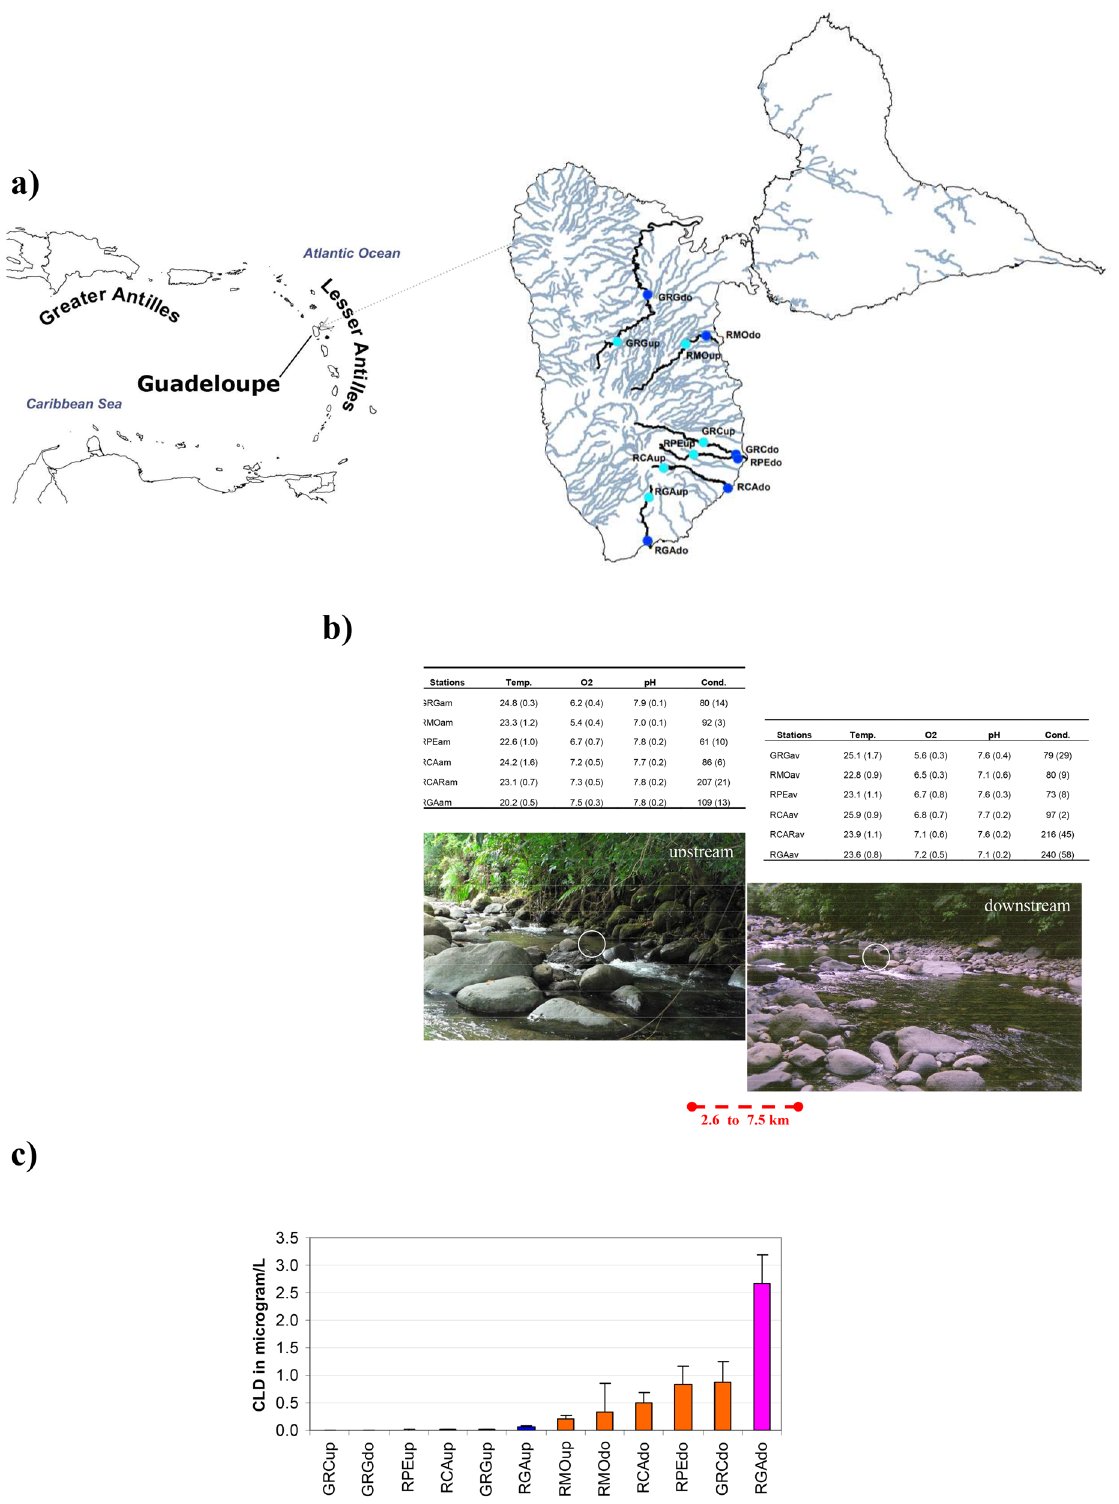
Figure 1. ( a ) Map of the sampling stations on the Basse-Terre region (French West Indies). Localisation of the upstream (lightblue) and downstream (darkblue) sampling sites in 6 different rivers. Grande rivière à Goyaves River: GRG, Moustique River: RMO, Grande rivière de Capesterre River: GRC, Pérou River: RPE, Carbet River: RCA, Grande Anse River: RGA. ( b ) Pictures showing the general configuration of the "upstream" and "downstream" stations, with values of temperature, O2 (mg/l), pH, conductivity, (s.d., N = 4) ( c ) Mean CLD contamination on the 12